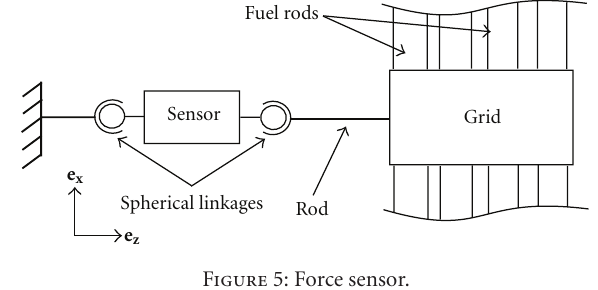
Figure 5: Force sensor.